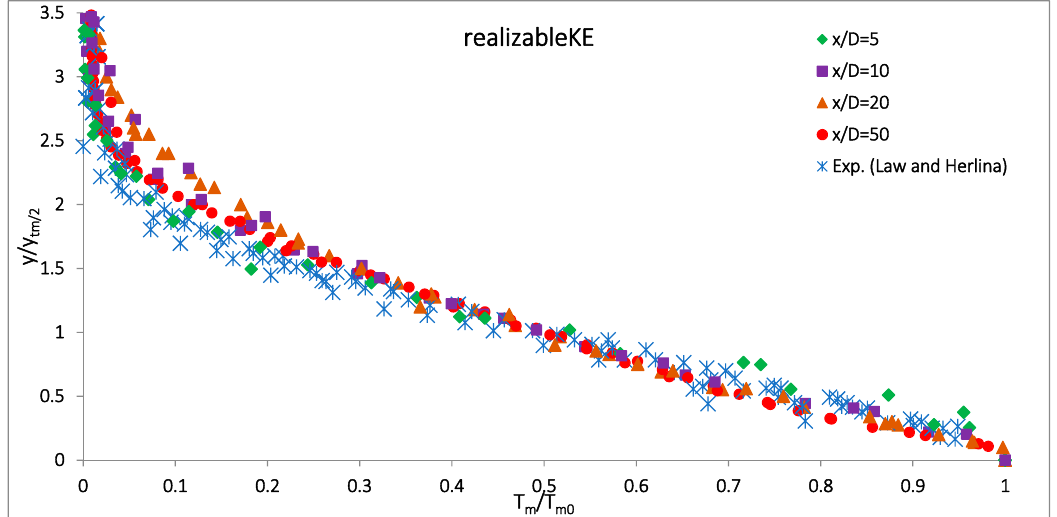
Figure 13. Stream-wise self-similarity temperature profiles for three cases at various cross-sections.